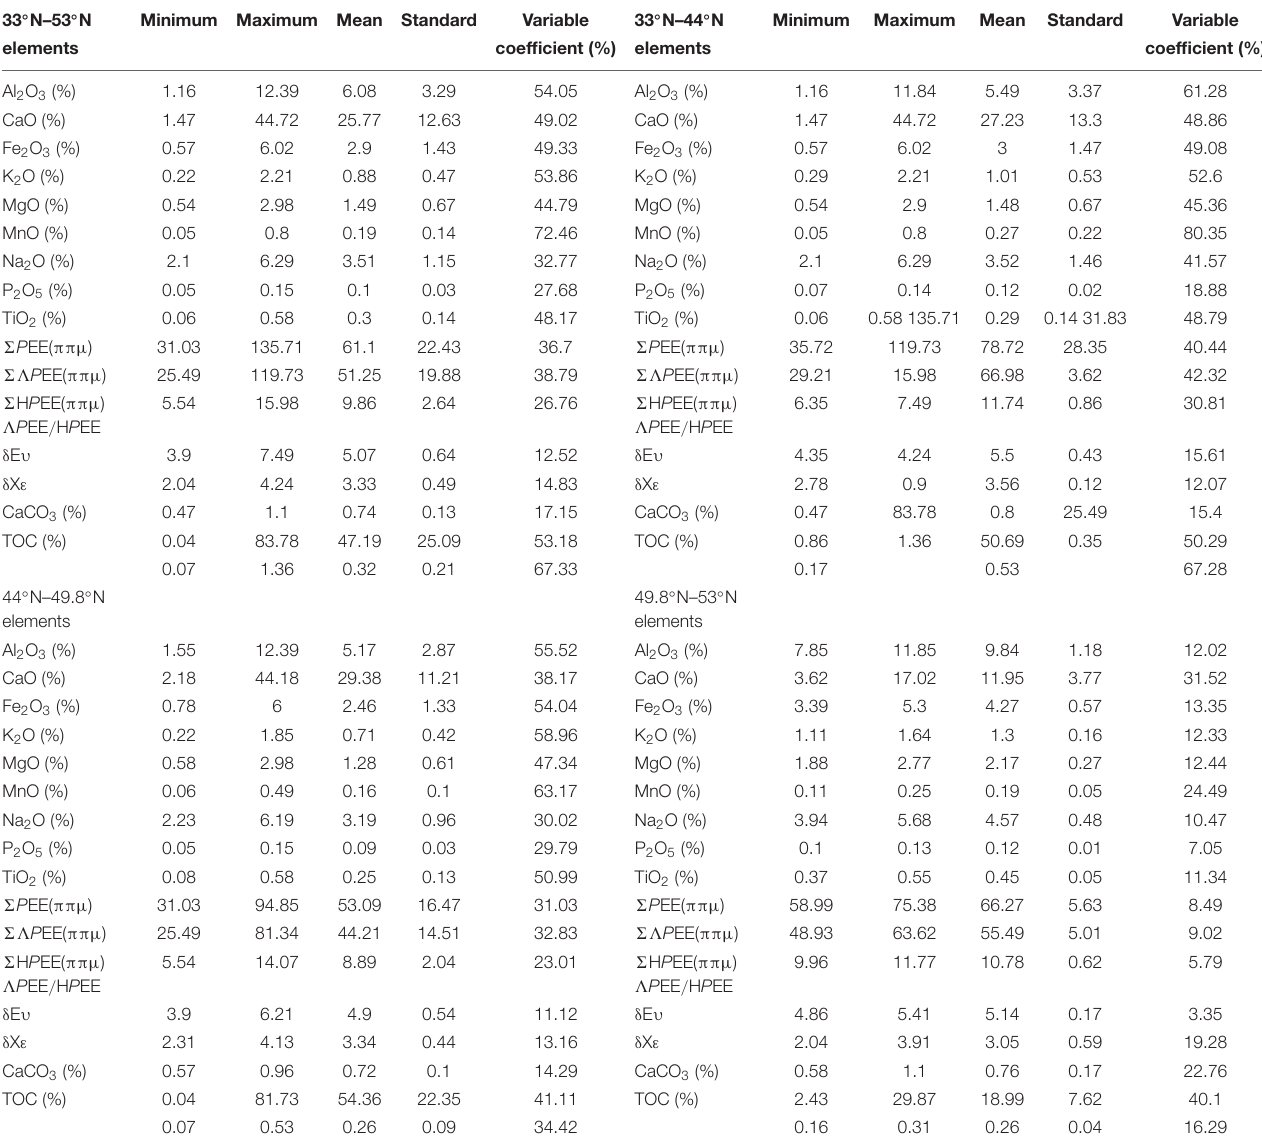
TABLE 3 | Statistical results of elemental concentrations of surface sediments in the study